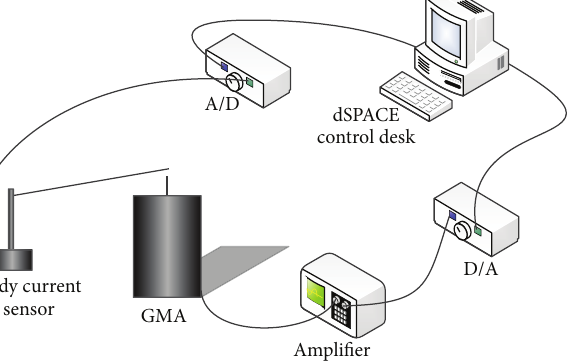
Figure 5: The diagram of experiment equipment.